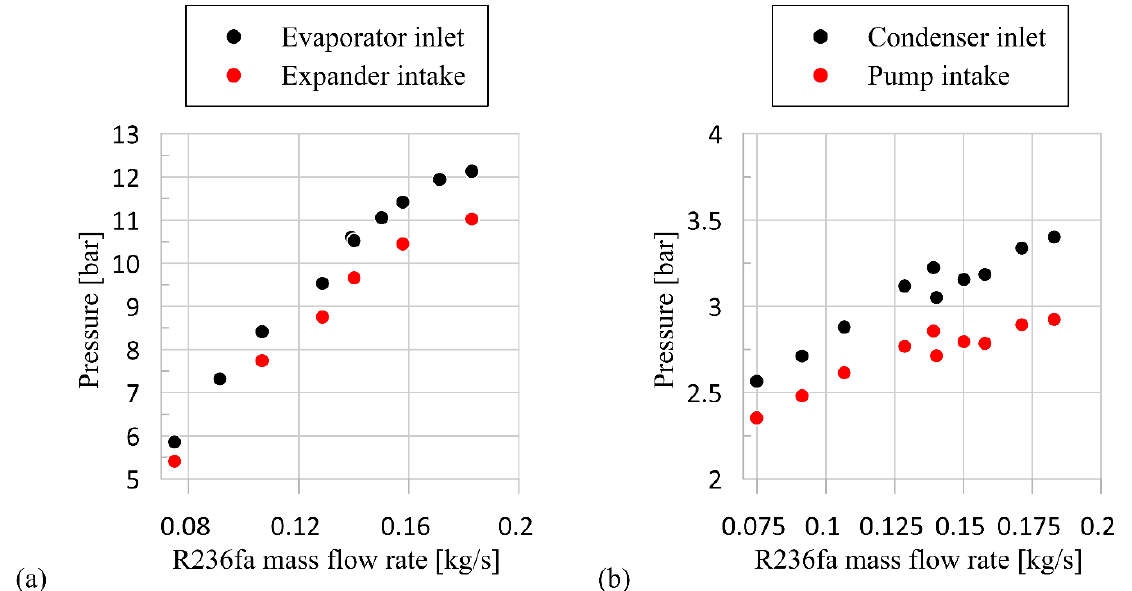
Figure 12. ( a ) Evaporator inlet and expander intake pressure; and ( b ) condenser inlet and pump intake pressure, all as function of the mass flow rate.